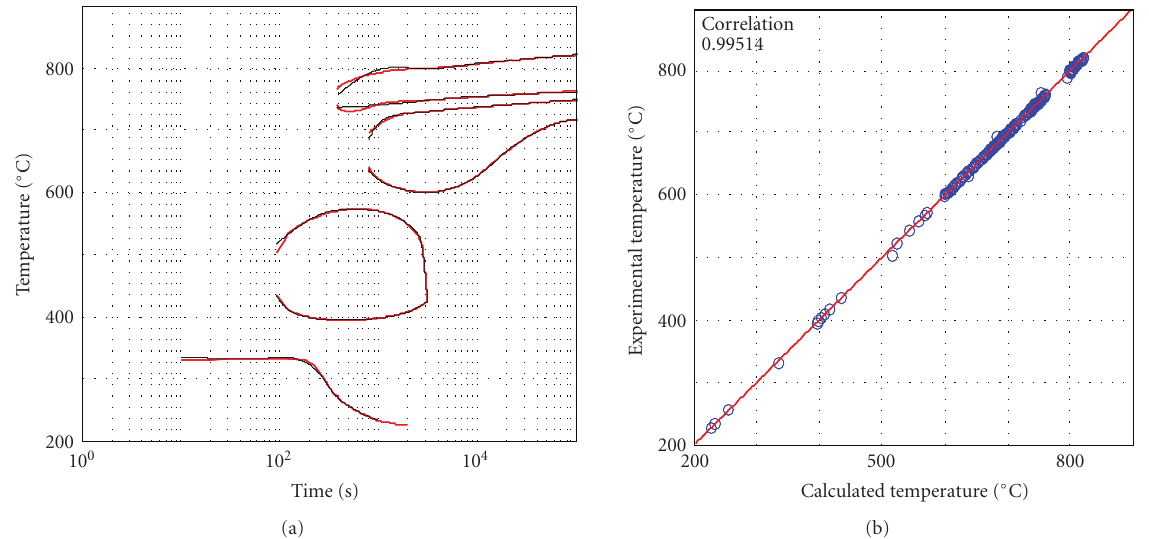
Figure 11: Results for tempering steel 34CrMo4 with a deformation of 0%.